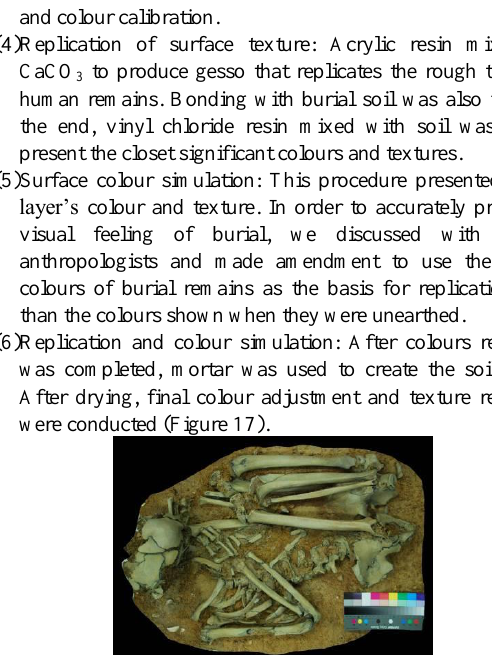
Figure 17. Completion of burial remains replication.